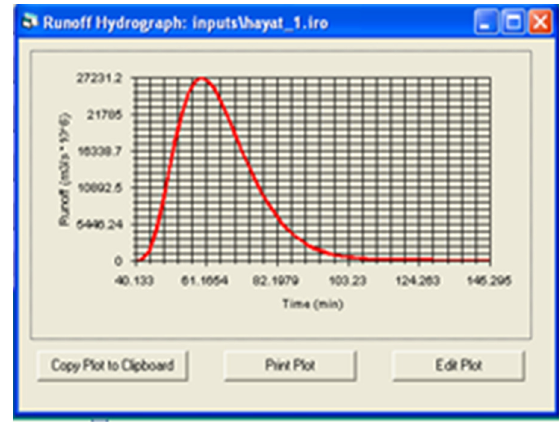
Fig. 4. Hydrograph of the case study using VFSMOD.